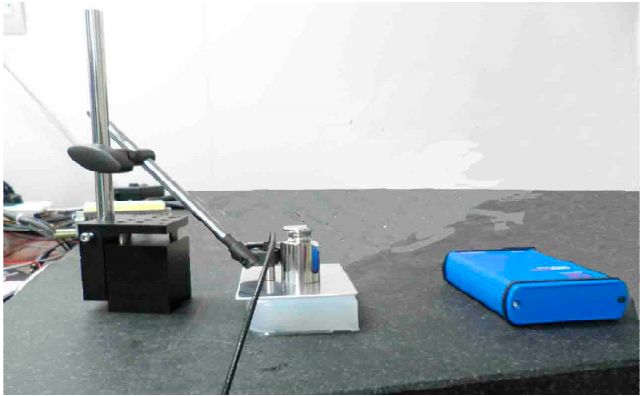
Figure 6. Measurement of Young’s modulus of the tissue.